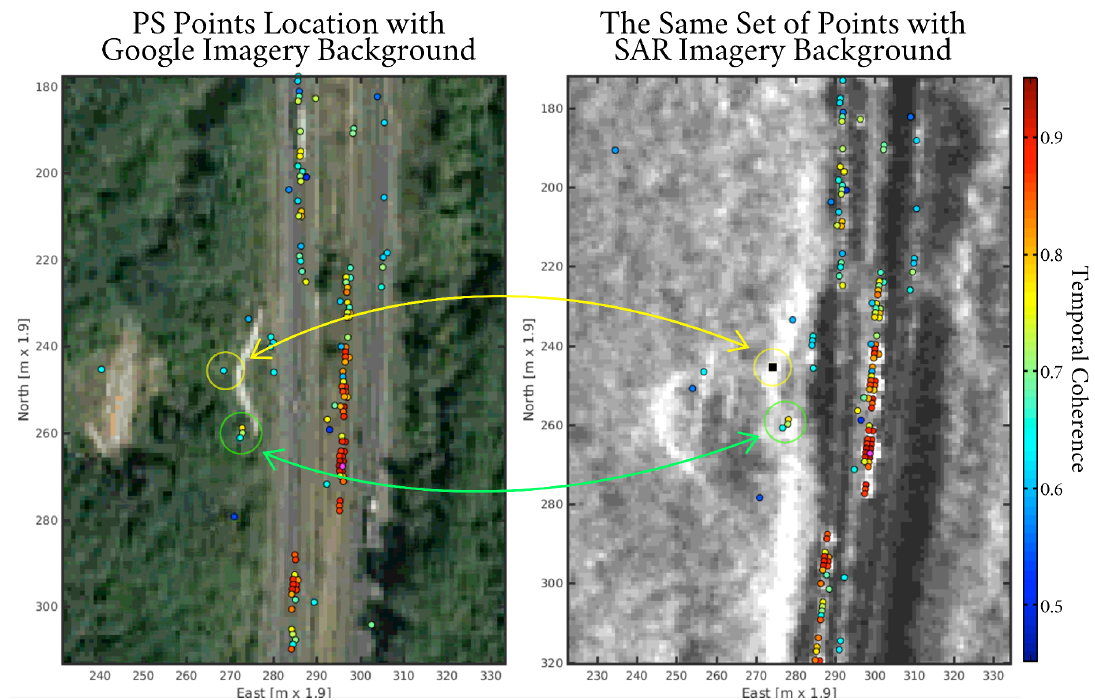
Figure 18. The location of points on SAR imagery and the geolocalization on Google Earth